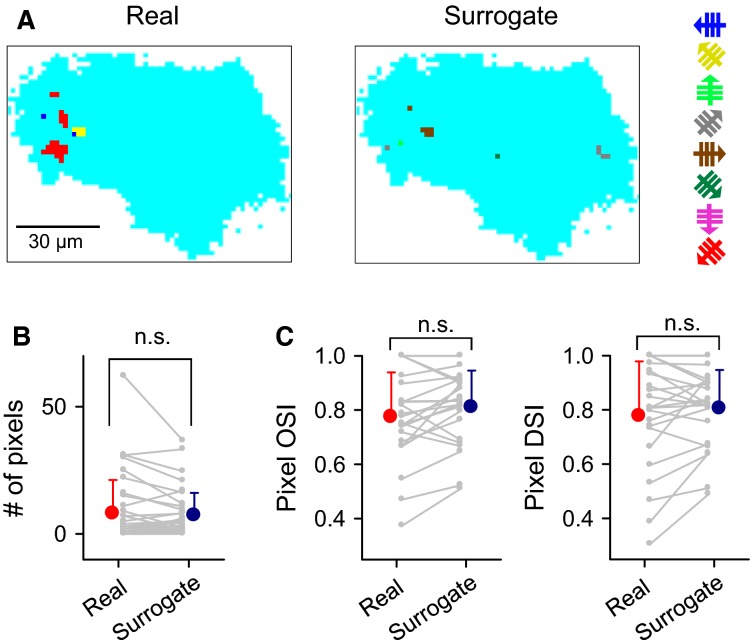
Nonsignificant orientation tuning of astrocytic calcium signals at the calcium domain level. (A), Map of pixels that responded at least twice to a single direction in real datasets (left) and 1000 trial-shuffled surrogates (right). Colors indicate the preferred directions to which each pixel responded most frequently. (B), Mean numbers of responsive pixels in 37 real datasets and their pixel-shuffled surrogates. Gray lines indicate single astrocytes, and error bars represent the SD. (C), Mean ± SD of OSIs (left) and DSIs (right) of the responsive pixels in 23 real datasets and their surrogate data.